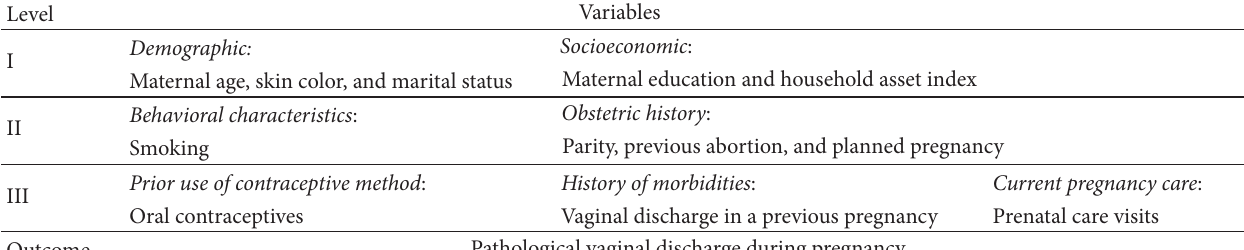
Table 1: Hierarchical model of analysis for factors associated with the occurrence of pathological vaginal